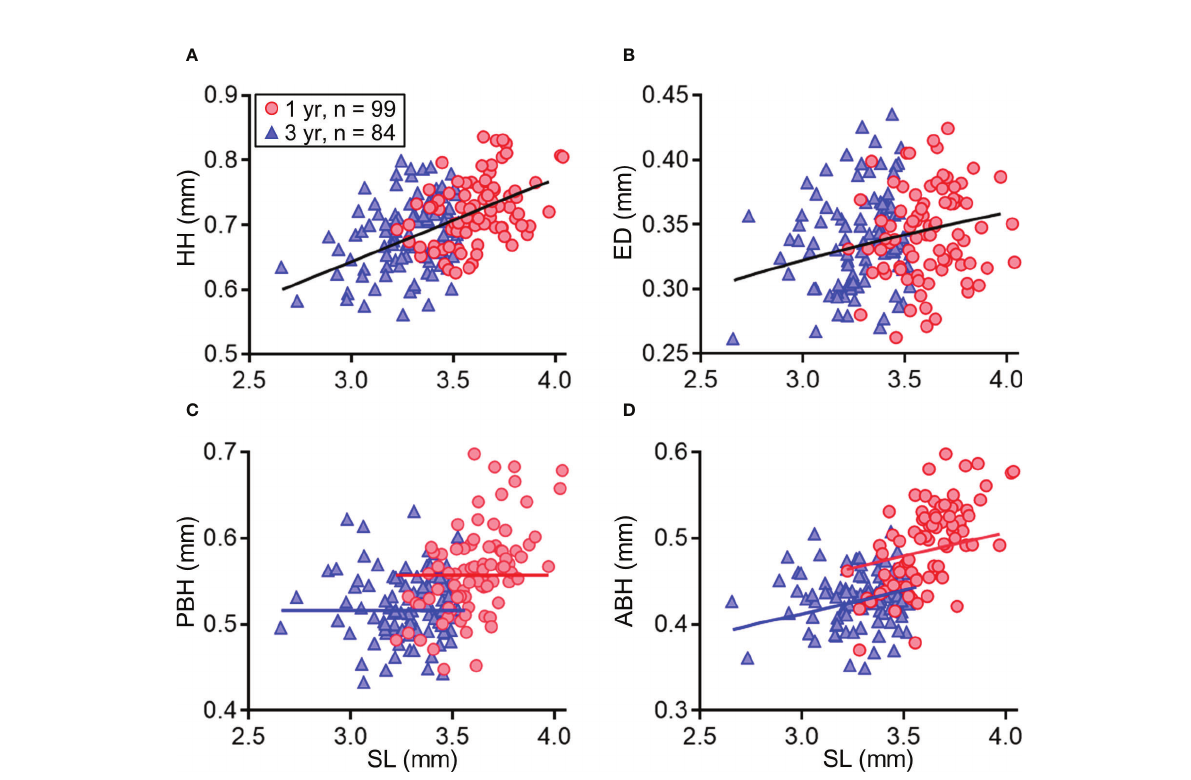
FIGURE 5 Morphological measurements of fi rst-feeding larvae of chub mackerel (A) and the effects of maternal age (1 or 3 years) on the relationships between body parts and standard length (SL; A – D ). Predicted lines using the linear mixed effect model fi tted to the observed data on head height (HH, A ), eye diameter (ED, B ), pectoral body depth (PBH, C ) and body depth at anus (ABH, D ) are shown in each maternal age class (black line: age 1 and 2 years; blue line: age 1 year; red line: age 3 years). Numbers indicate sample size.